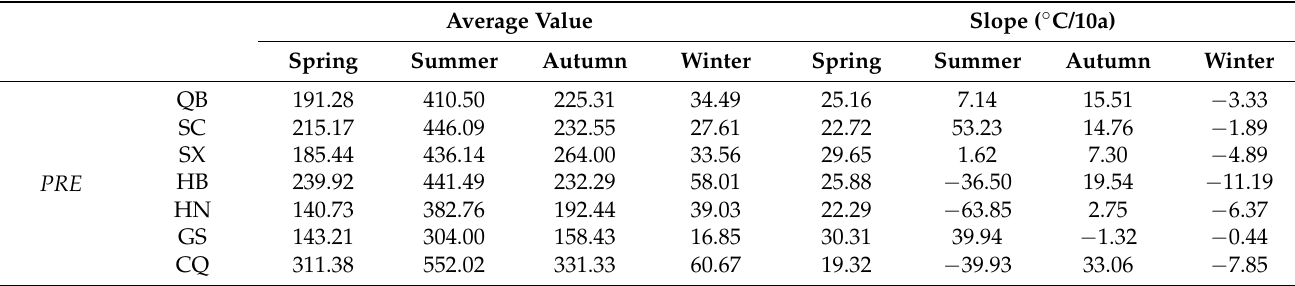
Figure 10. Change of seasonal average PRE spatial pattern in the QBM from 2000–2020. ( a ) Seasonal average; ( b ) Seasonal change trend rate. Table 7. Seasonal average and change trend rate of PRE in the QBM.